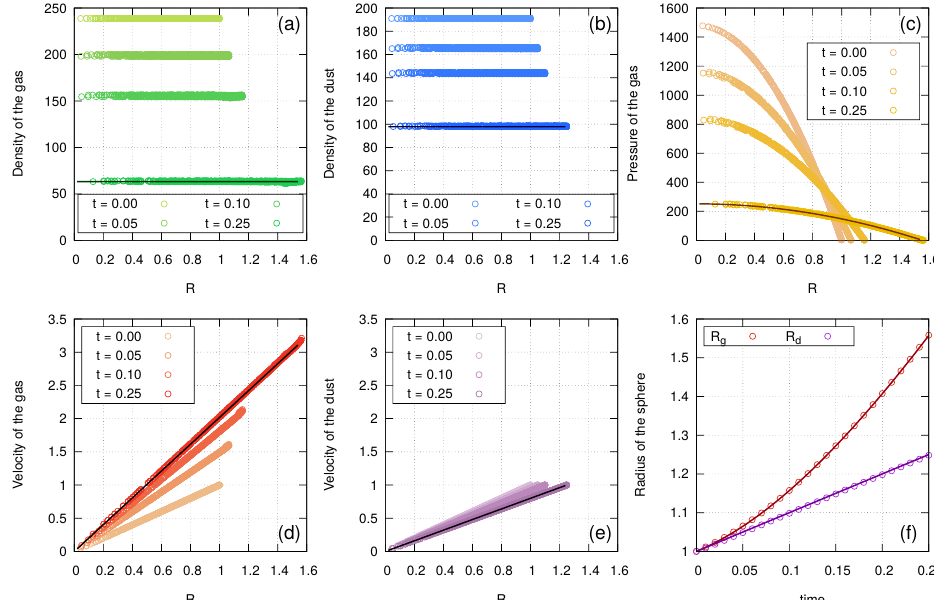
Figure 3. Expansion of a gas and dust ball into vacuum, model L with ε = 0.8 and long relaxation time ( t stop = 10 3 ). The points show the computed values at four time moments t = 0, t = 0.05, t = 0.1, and t = 0.25, the solid bold line is the analytical solution at the final time t = 0.25. The panels represent (from left to right and from top to bottom): gas density ( a ), dust density ( b ), gas pressure ( c ), gas velocity ( d ), dust velocity ( e ), and radii of the gas and dust balls, respectively ( f